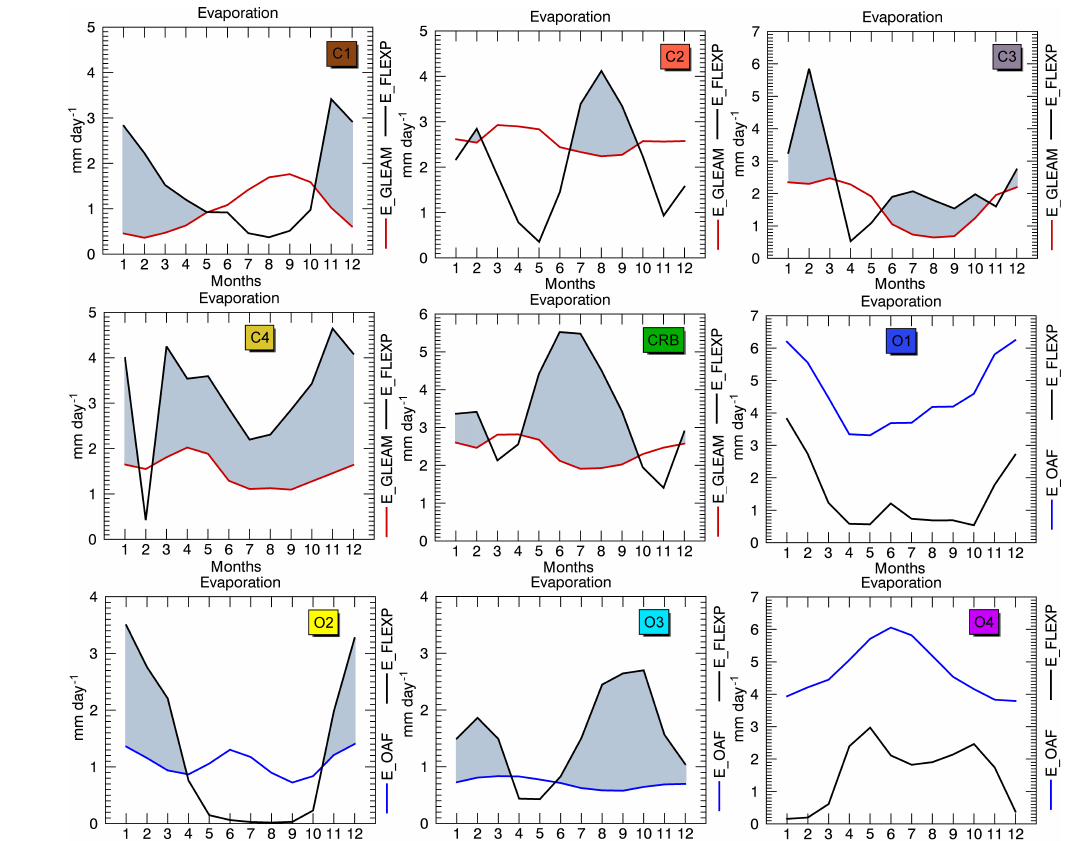
Figure 7. Monthly mean evaporation (mmday − 1 ) in the continental (C) and oceanic (O) sources. The data are from GLEAM (red lines) and OAFlux (blue lines). E-FLEX: evaporation values over the sources from FLEXPART (black lines). The areas that are shaded in grey mark where E-FLEX>evaporation. Data period: